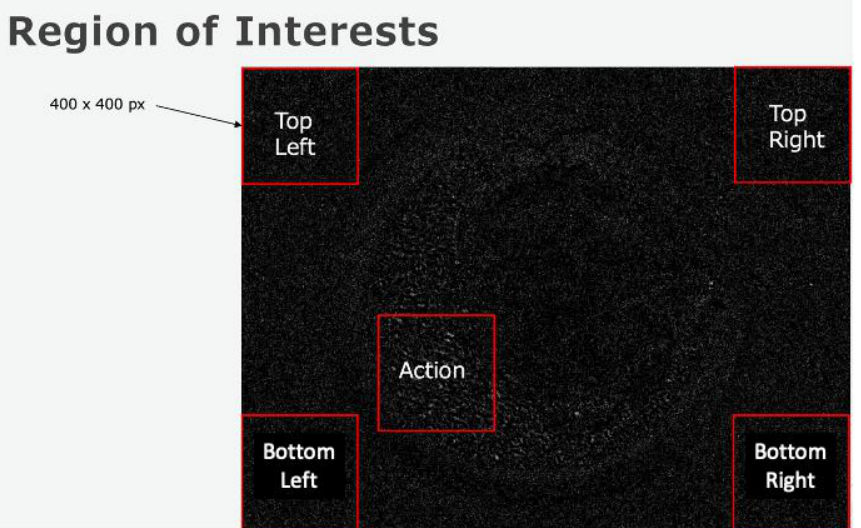
Figure 2. Five regions of interest were compared to evaluate the impact of environmental noise on the collected video data. Frame-by-frame changes in 400 × 400 pixel bounding boxes were assessed in regions of interest containing an action area containing live matter of the embryo proper, the top left corner external to the embryo, the top right corner external to the embryo, the bottom left corner external to the embryo, and the bottom right corner external to the embryo. Image collected from TE-300 inverted microscope, 400×.